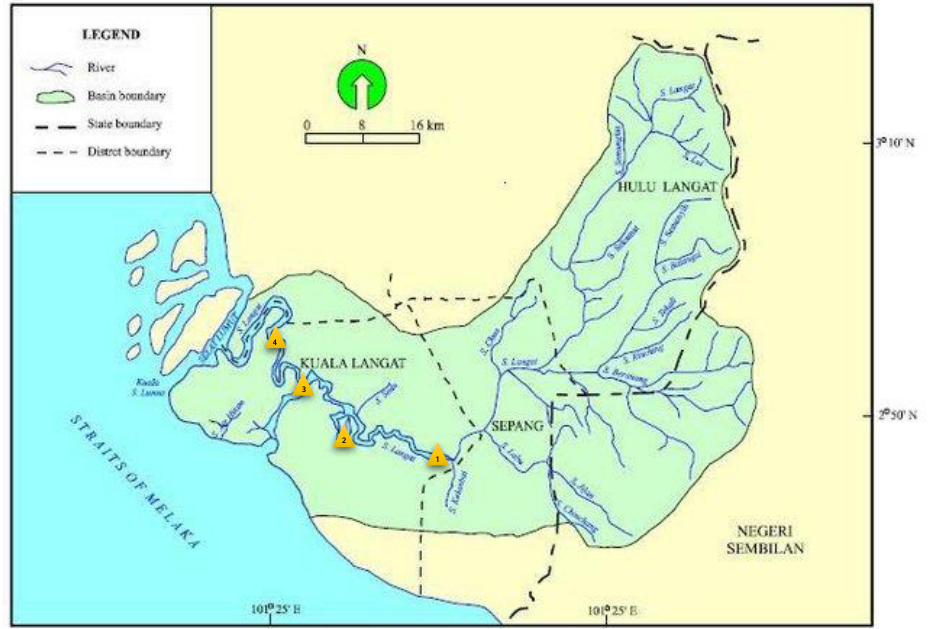
Figure 1. Water station on Langat River basin map.